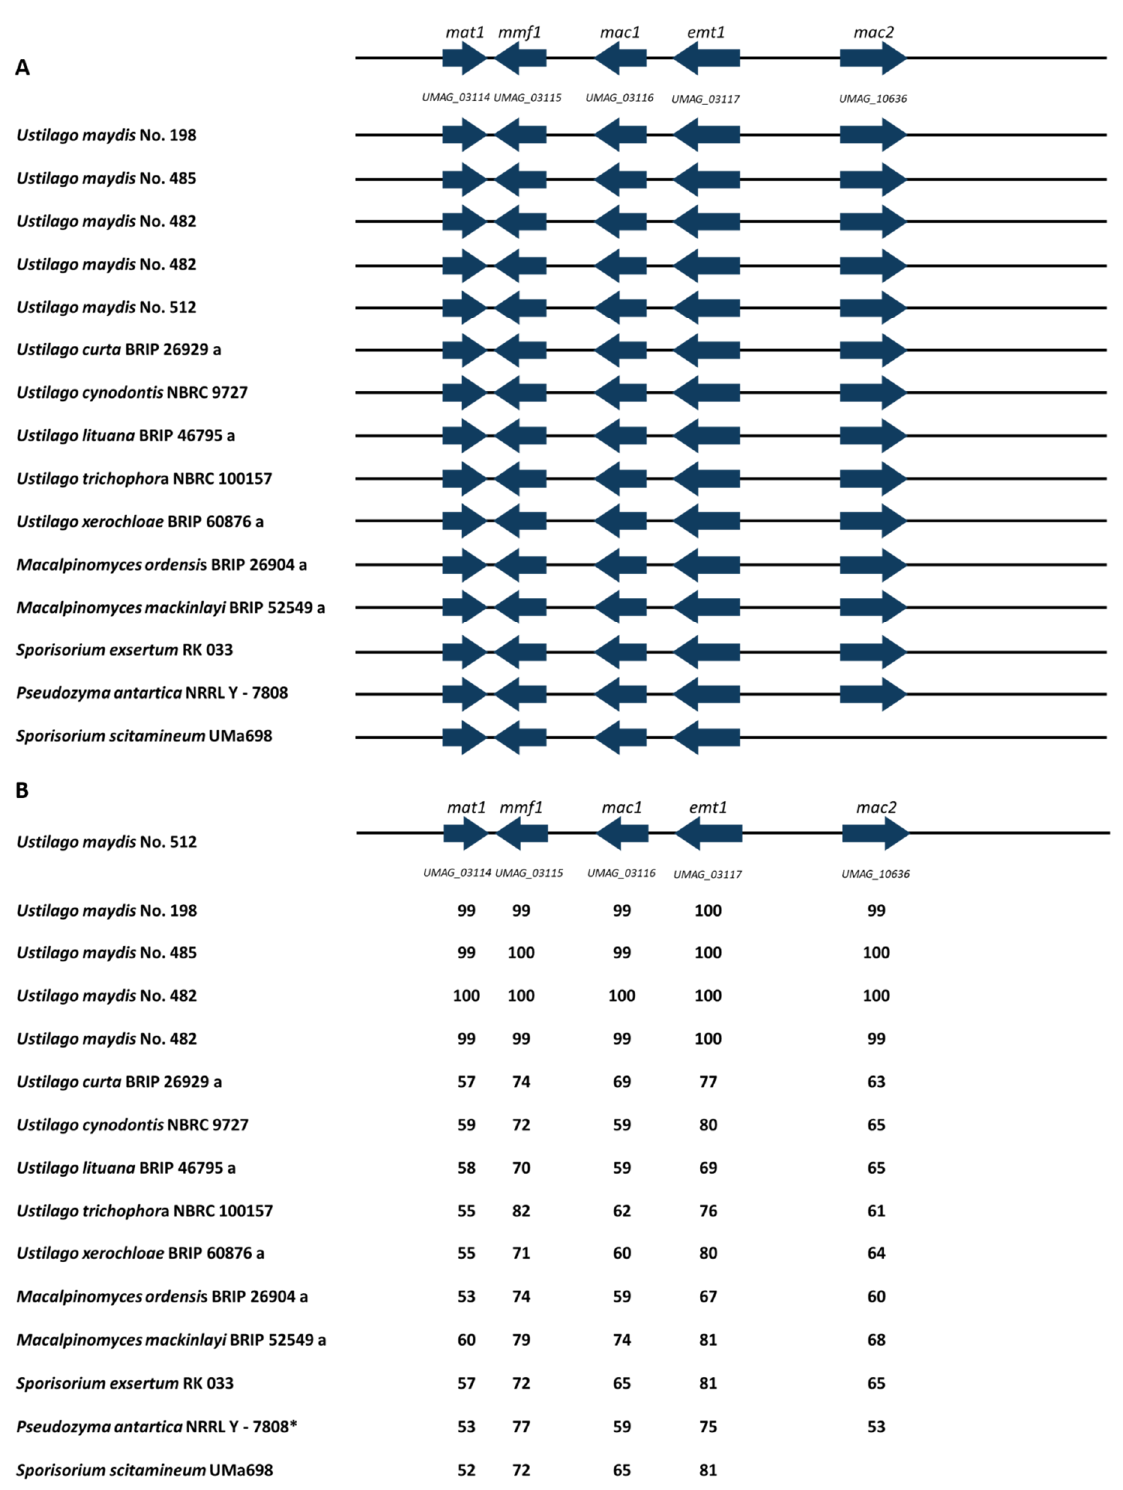
Figure 7. Schematic organization of the MEL synthesis gene cluster (modified from [65]) ( A ): Organi- zation of the gene cluster is compared to the sequenced Ustilaginaceae. Emt1 (erythritol/mannose transferase), mac1 and mac2 (acyl transferases), mat1 (acetyl transferase), mmf1 (putative transporter). ( B ): MEL gene cluster comparison of selected Ustilaginaceae. Numbers given represent amino acid sequence identity as percentage compared to the reference strain U. maydis No. 512 using antiSMASH 6.0 [58]. Two isolates were sequenced in case of U. maydis No.